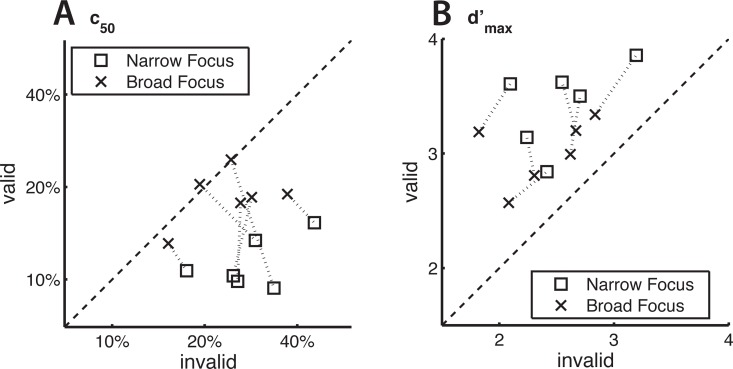
Population effects are also evident in single subjects.Data points indicate per subject fit coefficients c50 (A) and d′max (B), corresponding to coherence level at half maximum performance and asymptotic performance, respectively. For each subject, two Naka-Rushton equations per cue type were fit to the psychophysical data, revealing four informative coefficients. A decrease in c50 between validly and invalidly cued trials indicates a contrast gain effect and an increase in d′max a response gain effect. Dashed lines connect data points originating from the same subjects.